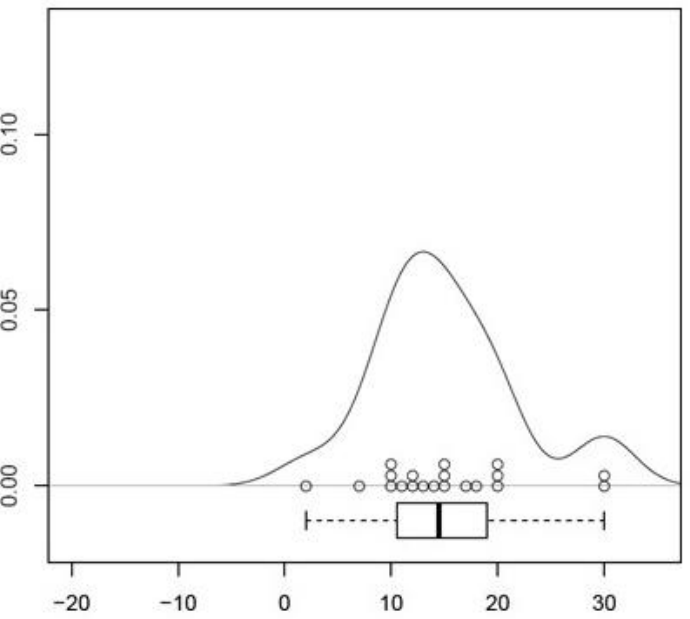
Figure 4. Visualization of the results of measurement on the right side as density-analysis. Scaling in mm. The percental spreading of the single results is displayed on the y -axis.